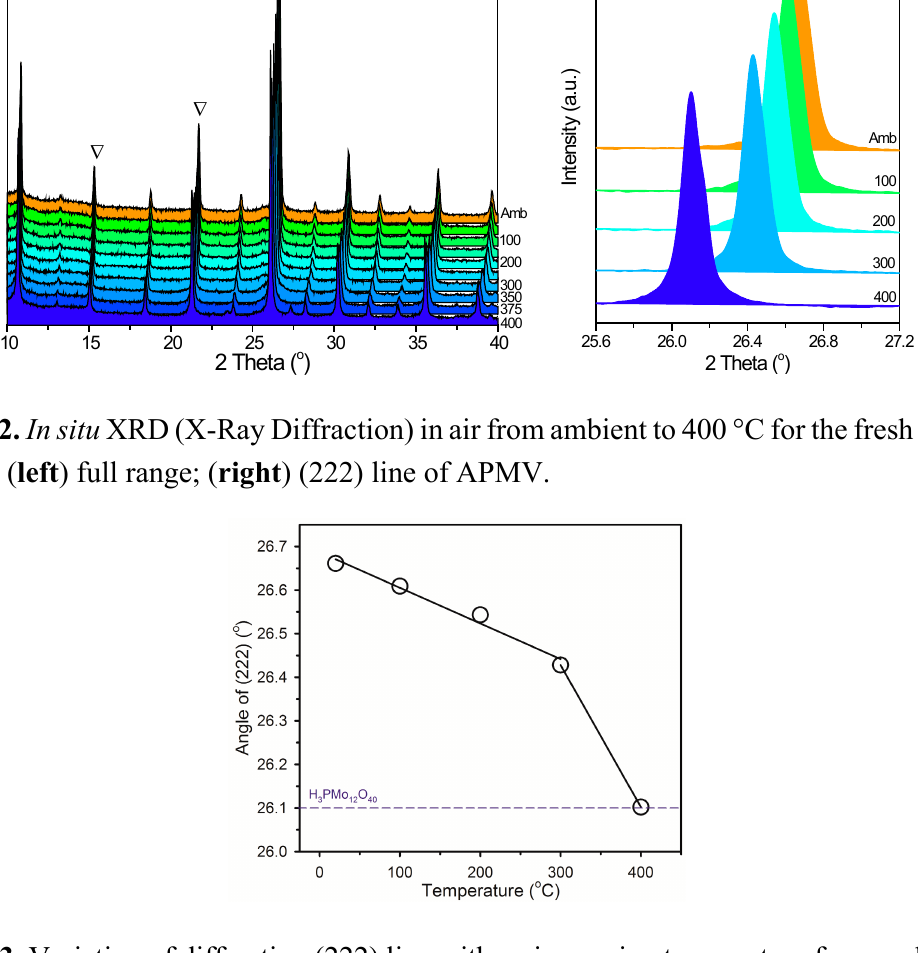
Figure 3. Variation of diffraction (222) line with an increasing temperature from ambient to 400